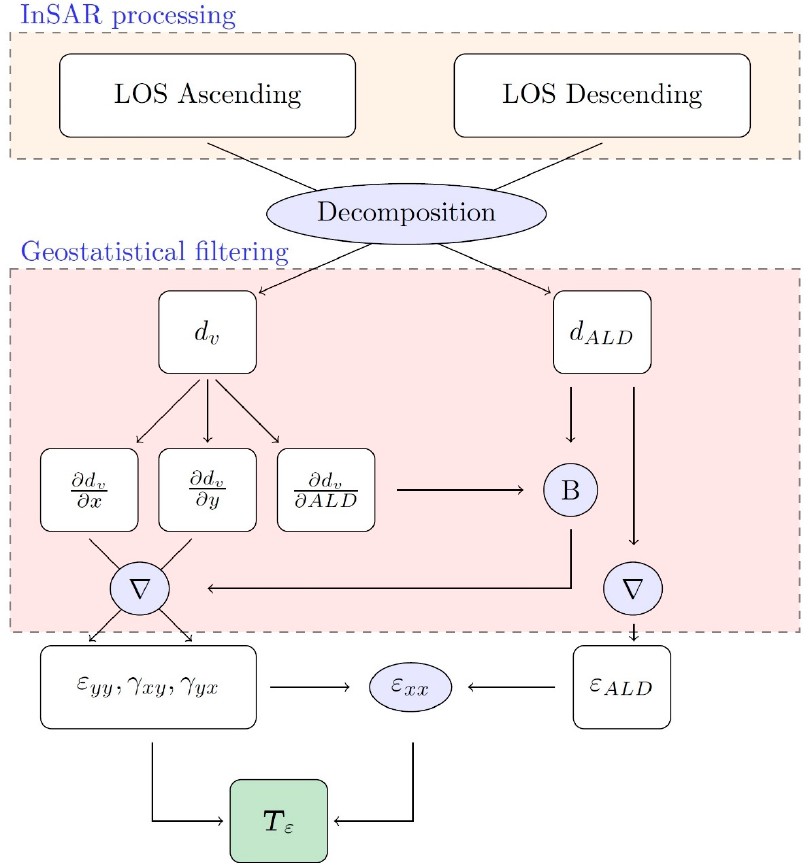
Figure 4. The flowchart of the research methodology.